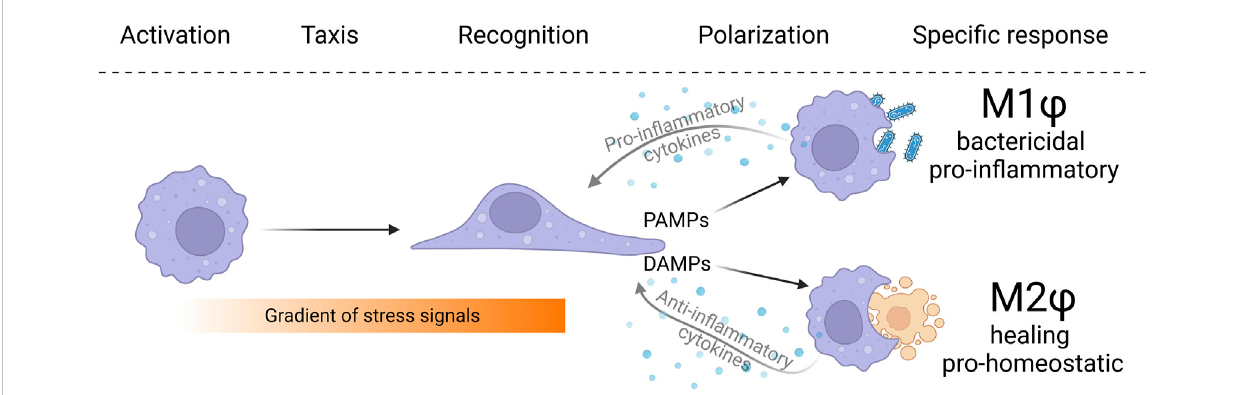
FIGURE 1 The typical macrophage behavior in tissues can be split into several consecutive phases. Macrophages fi rst perceive activation signals indicating changes in tissue homeostasis. Subsequently, macrophages migrate against the concentration gradient toward the source of activating signals. Macrophages in fi ltrating disharmonious tissue are exposed to local signals in the form of pathogen-associated molecular patterns (PAMPs), danger- associated molecular patterns (DAMPs), and a cocktail of pro-in fl ammatory and anti-in fl ammatory cytokines. Based on extrinsic cues and intrinsic predetermination, macrophages adjust their metabolic setup and functionally polarize to M1 and M2 polarization phenotypes (in a simplistic view of the problematics).Macrophages,inanefforttoresolveastressfulsituation,engulfandeliminatepathogenicbacteria,orremovesenescentanddysfunctional cells to restore tissue